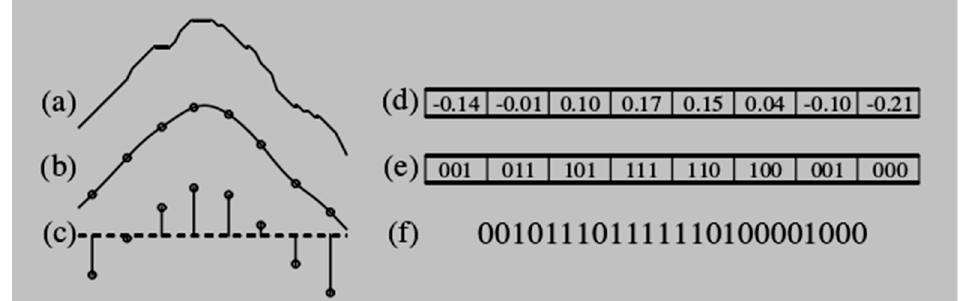
Figure 1. Representing a skyline with contour word. A section of skyline ( a ) is sampled and normalized ( b – d ), and each sampling point is encoded with 3 bits ( e ). The contour word ( f ) of the skyline is formed by concatenating the codes of each sampling point.